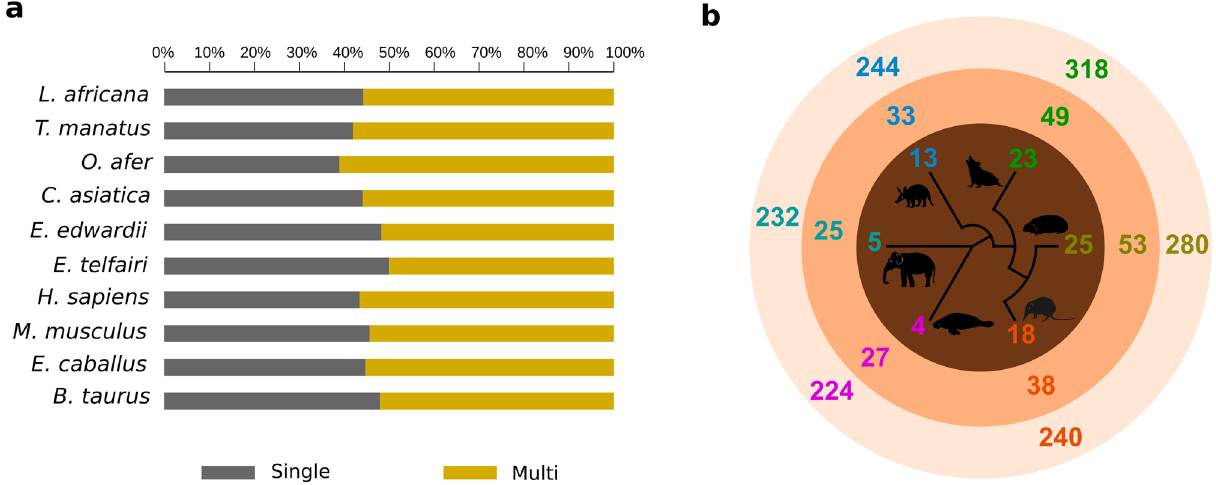
Figure 5. Distribution of structural domains in Afrotheria. ( a ) Bar plot shows the proportion of SCOP ‘multi-domain’ class in single (grey) and multi-domain (gold) proteins in various species. ( b ) Distribution of structural domain architectures in Afrotherian proteomes. Numbers in the outer circle (light pink) represent the total number of unique domain architectures observed in L. africana (blue), T. manatus (pink), O. afer (dark blue), C. asiatica (orange), E. edwardii (gold) and E. telfairi (green) upon comparisons within Afrotheria. Numbers in the middle circle (orange) show the number of unique domain architectures in each